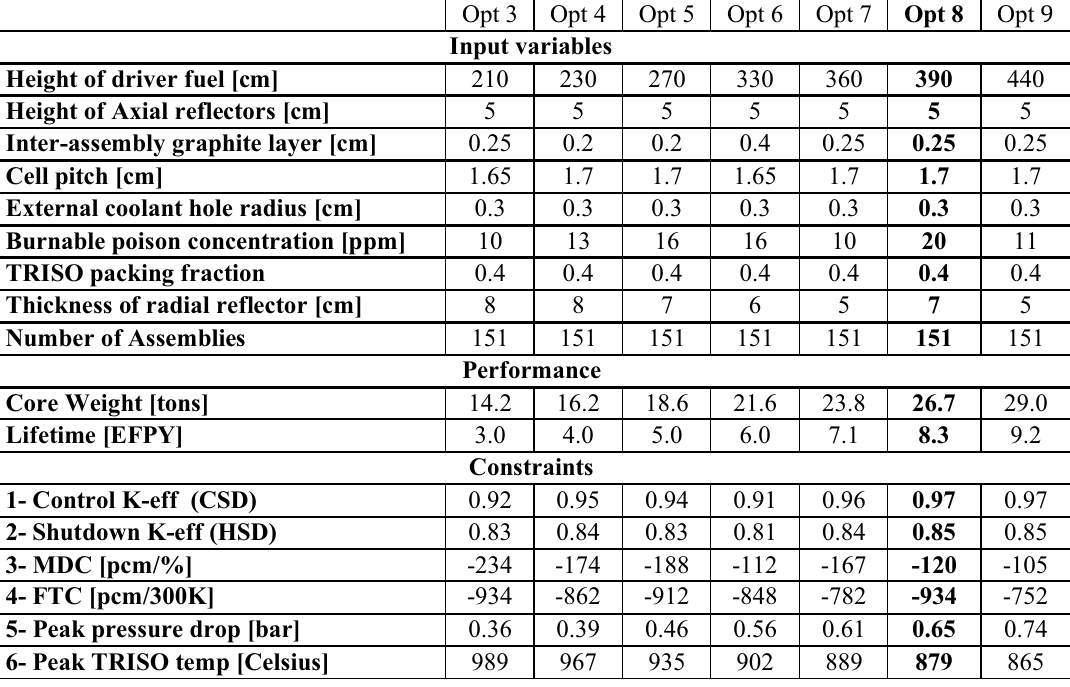
Table 4. Sample of optimum core